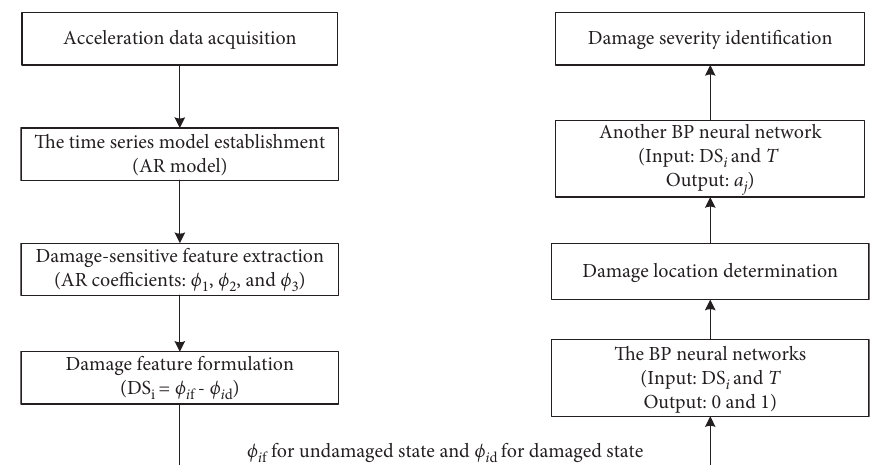
Figure 2: Flowchart of the proposed damage identification approach.